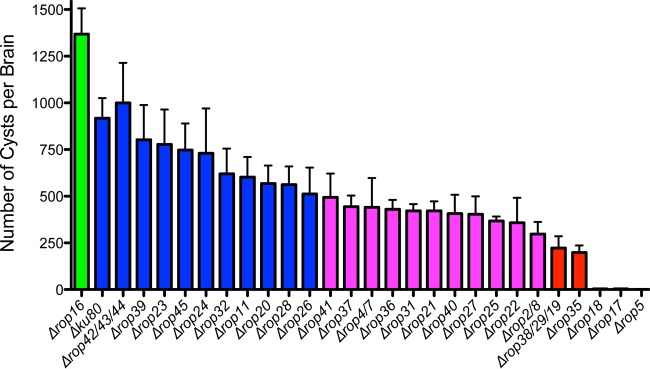
Rhoptry kinome molecules are essential for chronic infection. C57BL/6 mice were infected i.p. with 200 tachyzoites of each strain, and brain cyst burdens were measured 21 days postinfection. Data shown are cumulative results from one to three independent experiments for each strain tested. ROPK knockout strains and the Δku80 parent strain are organized in descending order by cyst number for each strain, with cyst numbers shown as means plus standard errors of the means (SEM) (error bars). P values were calculated by a Student’s t test, and a P < 0.05 (shown in purple or red color) was considered significant. Data on the ROPK knockout strains and the Δku80 parent strain follow: Δrop16 (two experiments; n = 6 mice; P = 0.0242), Δku80 parent (three experiments; n = 12 mice), Δrop42/43/44 (one experiment; n = 4 mice; P = 0.7188), Δrop39 (two experiments; n = 7 mice; P = 0.5691), Δrop23 (one experiment; n = 4 mice; P = 0.5232), Δrop45 (one experiment; n = 4 mice; P = 0.4186), Δrop24 (one experiment; n = 4 mice; P = 0.4259), Δrop32 (one experiment; n = 4 mice; P = 0.1651), Δrop11 (two experiments; n = 7 mice; P = 0.0703), Δrop20 (two experiments; n = 6 mice; P = 0.0534), Δrop28 (one experiment; n = 4 mice; P = 0.0928), Δrop26 (two experiments; n = 5 mice; P = 0.0500), Δrop41 (two experiments; n = 5 mice; P = 0.0384), Δrop37 (two experiments; n = 5 mice; P = 0.0154), Δrop4/7 (three experiments; n = 12 mice; P = 0.0198), Δrop36 (two experiments; n = 6 mice; P = 0.0070), Δrop31 (two experiments; n = 6 mice; P = 0.0058), Δrop21 (two experiments; n = 7 mice; P = 0.0036), Δrop40 (one experiment; n = 4 mice; P = 0.0217), Δrop27 (two experiments; n = 6 mice; P = 0.0073), Δrop25 (two experiments; n = 7 mice; P = 0.0013), Δrop22 (two experiments; n = 5 mice; P = 0.0095), Δrop2/8 (one experiment; n = 4 mice; P = 0.0063), Δrop38/29/19 (two experiments; n = 8 mice; P < 0.0001), Δrop35 (two experiments; n = 8 mice; P < 0.0001), Δrop18 (two experiments; n = 8 mice; P < 0.0001), Δrop17 (two experiments; n = 8 mice; P < 0.0001), and Δrop5 (three experiments; n = 9 mice; P < 0.0001).